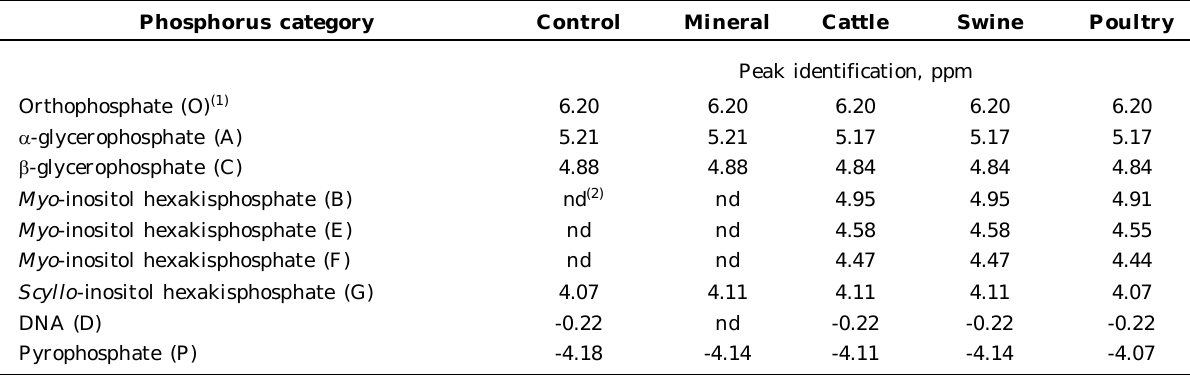
(1) Letters in parentheses indicate the NMR peaks in figure 1; (2) nd: not